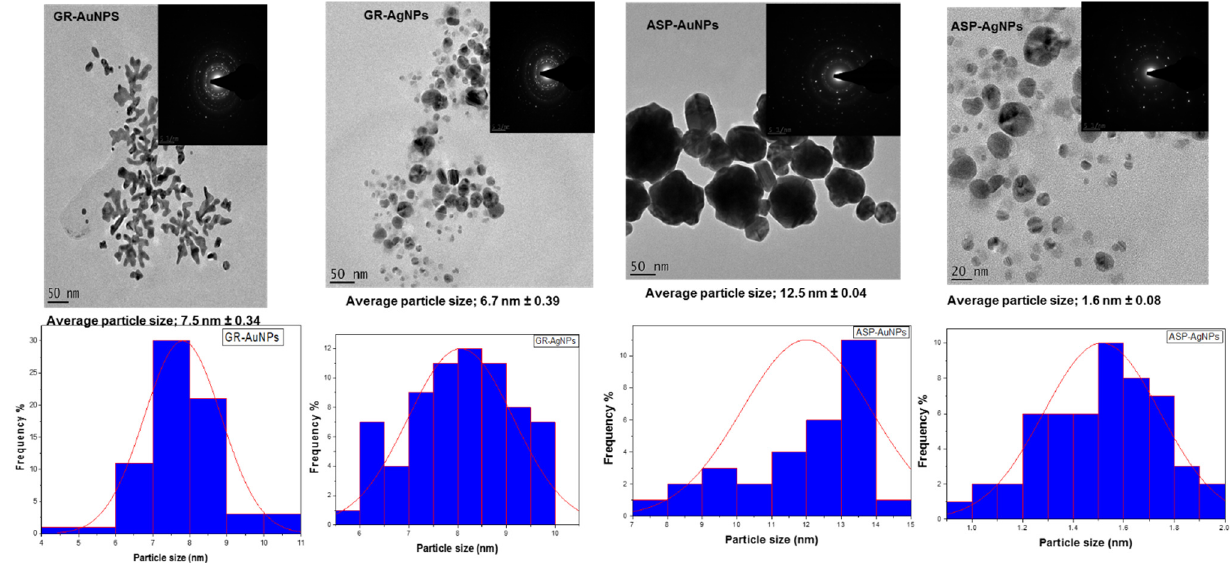
Figure 3. HRTEM images (left–right) for the GR-AuNPs, GR-AgNPs, ASP-AuNPs, and ASP-AgNPs. The corresponding insets are the SAED of the respective TEM images.